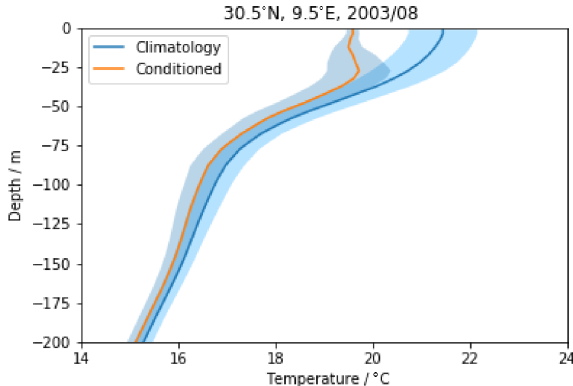
Figure 3. Example of the effect of conditioning climatology using SST from SST_cci, for a single time and location (30.5 ◦ N, 9.5 ◦ E; August 2003). Unconditioned (blue) and conditioned (orange) tem- perature profiles with their uncertainty ranges (shaded